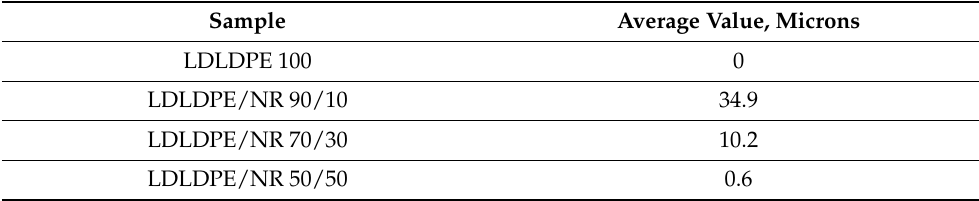
Figure 2. The microphotographs of initial samples: LDPE 100 ( a ), LDPE/NR 90/10 ( b ), LDPE/NR 70/30 ( с ), LDPE/NR 50/50 ( d ).